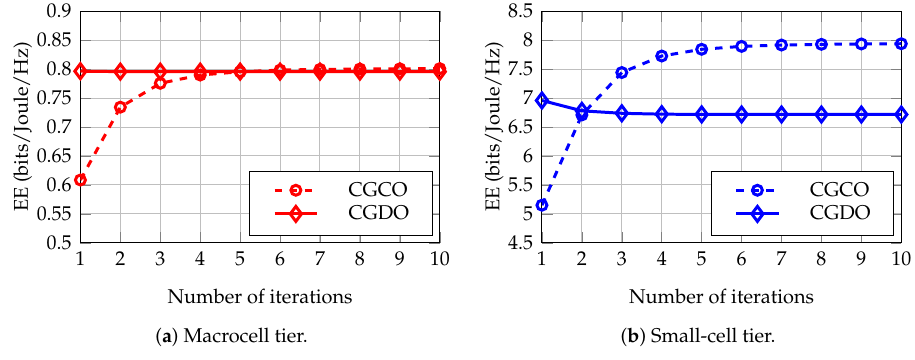
Figure 5. The convergence speed of the two PA